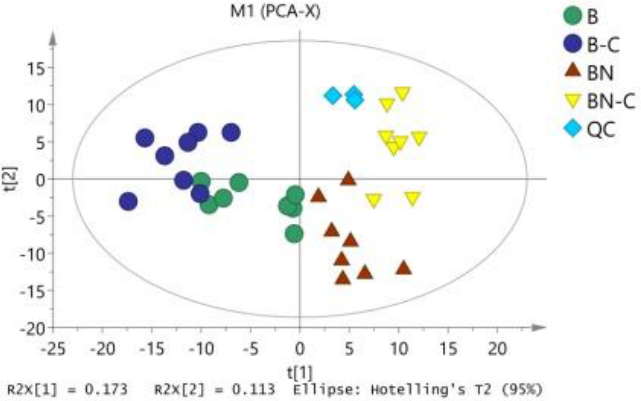
Table 1. Inter-sample PCA and OPLS-DA analysis-related parameters.